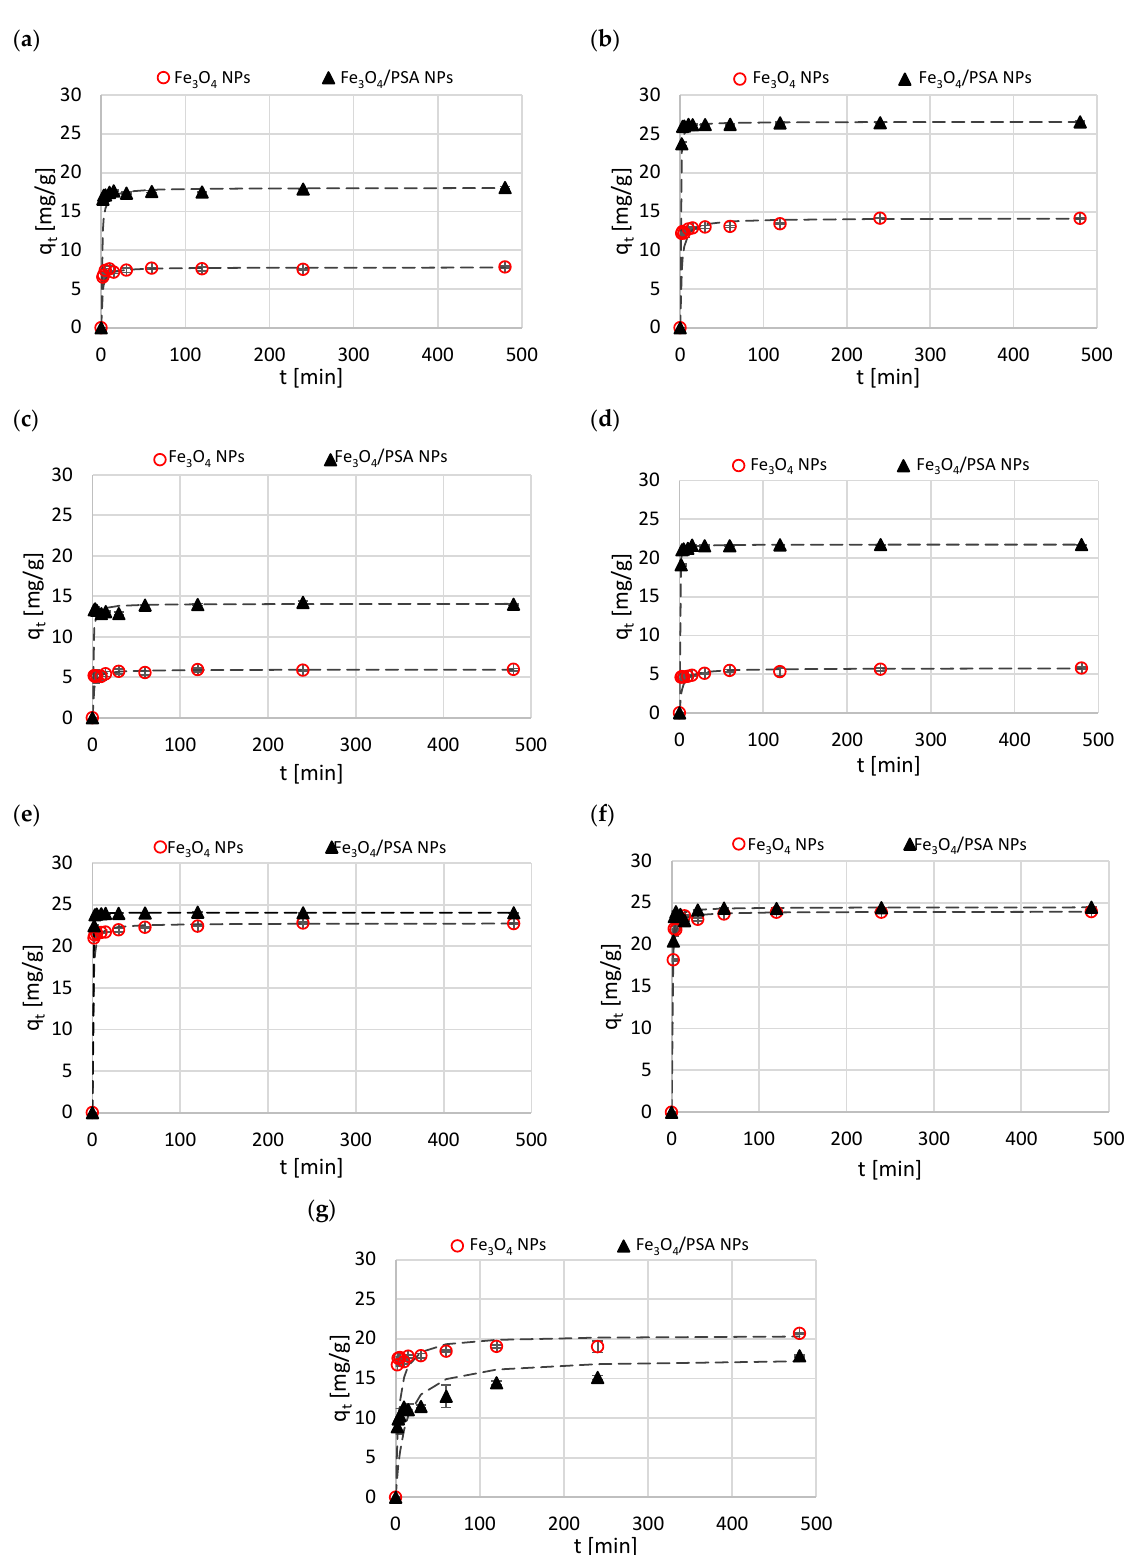
Figure 8. Kinetics of adsorption of Zn(II) ( a ), Cu(II) ( b ), Ni(II) ( c ), Cd(II) ( d ), Pb(II) ( e ), Cr(III) ( f ), Cr(VI) ( g ) on Fe 3 O 4 NPs and Fe 3 O 4 /PSA NPs at pH = 5. Table 2. Parameters of the applied kinetic models.